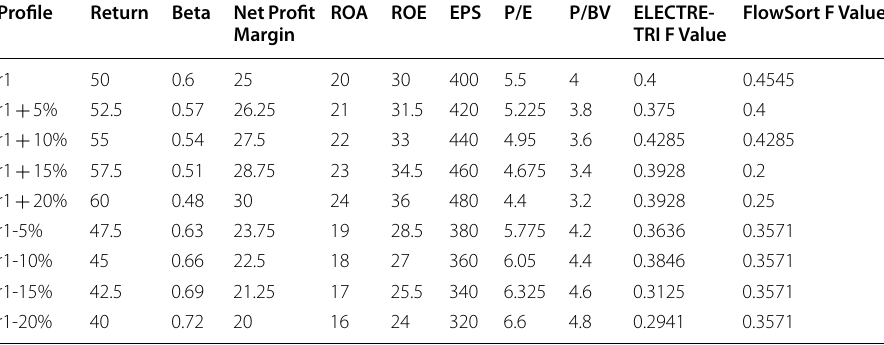
Table 11 Sensitivity analysis on profile r